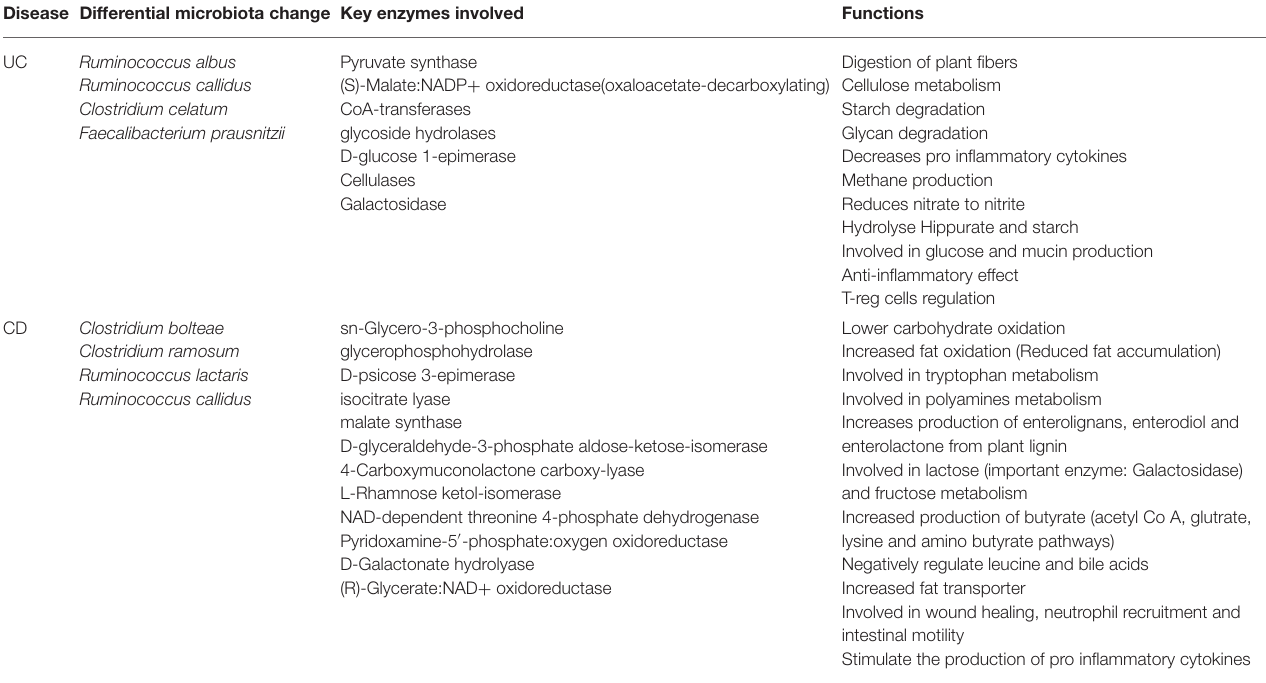
TABLE 2 | Differential microbiome patterns, metabolites, and metabolic function changes in CD vs. UC. Disease Differential microbiota change Key enzymes involved